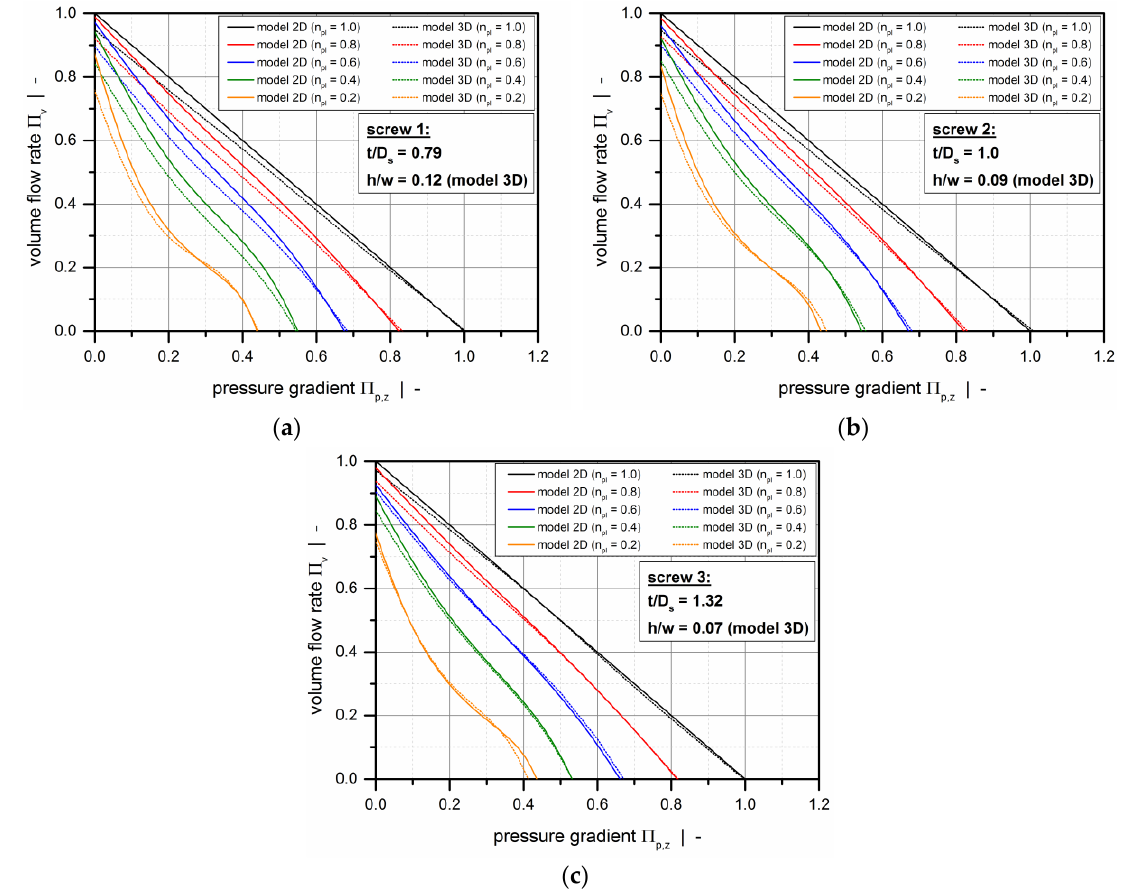
Figure 6. Comparison between model 2D and model 3D: Screw characteristic curves for the metering channels experimentally investigated in the first part (Table 5) and various power-law indices: Screw 1 ( a ), screw 2 ( b ), and screw 3 ( c ).